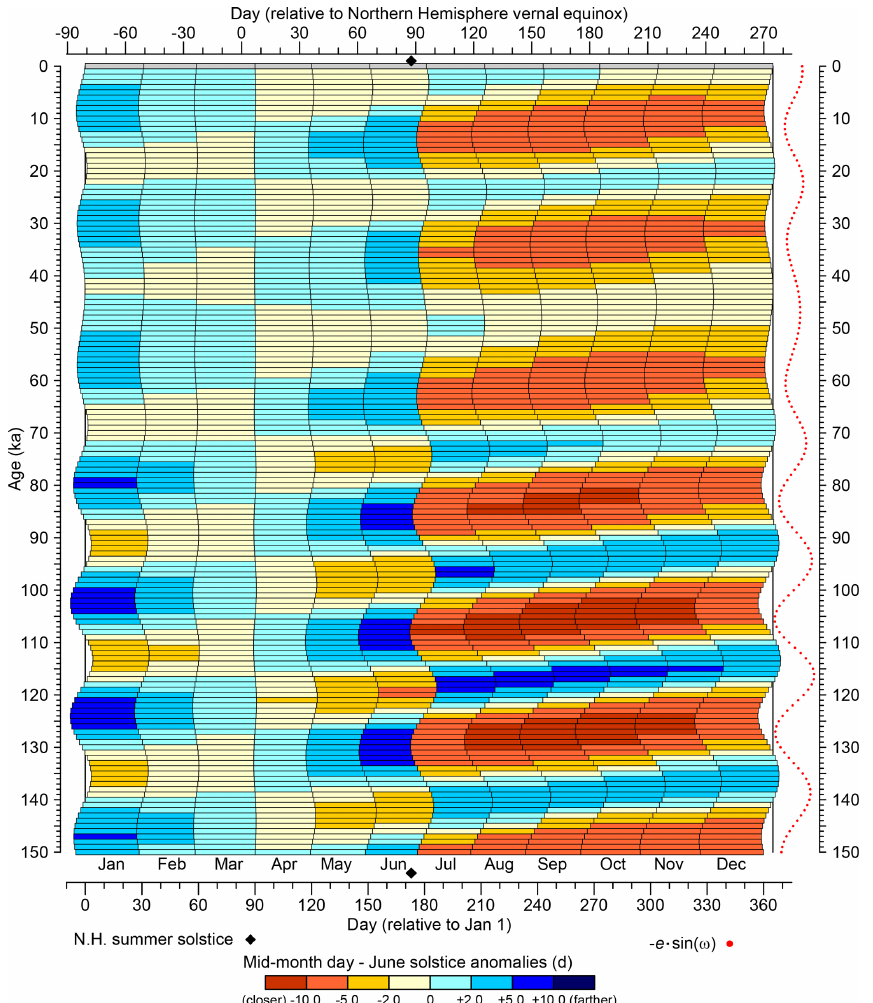
Figure 2. Variations in the difference (in days) between the mid-month day of each month and the day of the June solstice. Months that are shifted closer to the June solstice are indicated by orange hues, while those that are farther away are indicated by blue. As in Fig. 1, variations over the past 150kyr in the beginning and ending days of fixed-angular months for a 365d noleap calendar are shown for 1kyr intervals beginning at 0ka (1950 CE). The left side of each horizontal bar shows the beginning day, while the right side shows the ending day of a particular month for each 1kyr interval. Variations in the beginning and ending days of individual months can be seen to track the climatic precession parameter ( e · sin ω , where e is eccentricity and ω is the longitude of perihelion measured from the vernal equinox, an index of Earth’s distance from the Sun at the summer solstice), which is plotted at the right side of the figure (red dots). (Note that the inverse of the climatic precession parameter is plotted for easier comparison.) The day of the Northern Hemisphere summer solstice is indicated by a black diamond on the x